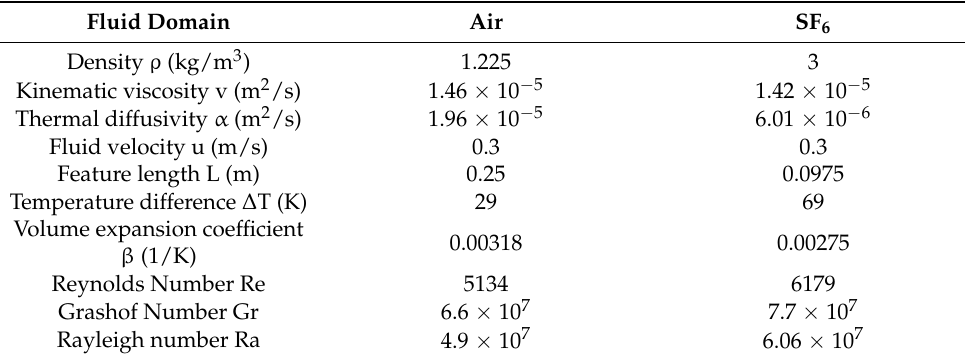
Table 1. Calculated parameters of the GIS disconnect switch flow field.